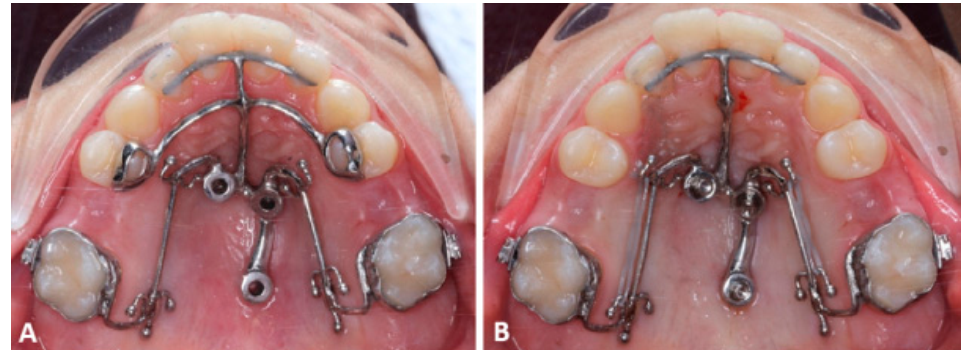
Figure 7. DIVA appliance positioned in the oral cavity. ( A ) After cementation of the appliance at the level of molar bands, incisal and premolar rests. ( B ) After insertion of miniscrews through the bushings and placement of elastic chains between the hooks. Occlusal rests on premolars are cut and